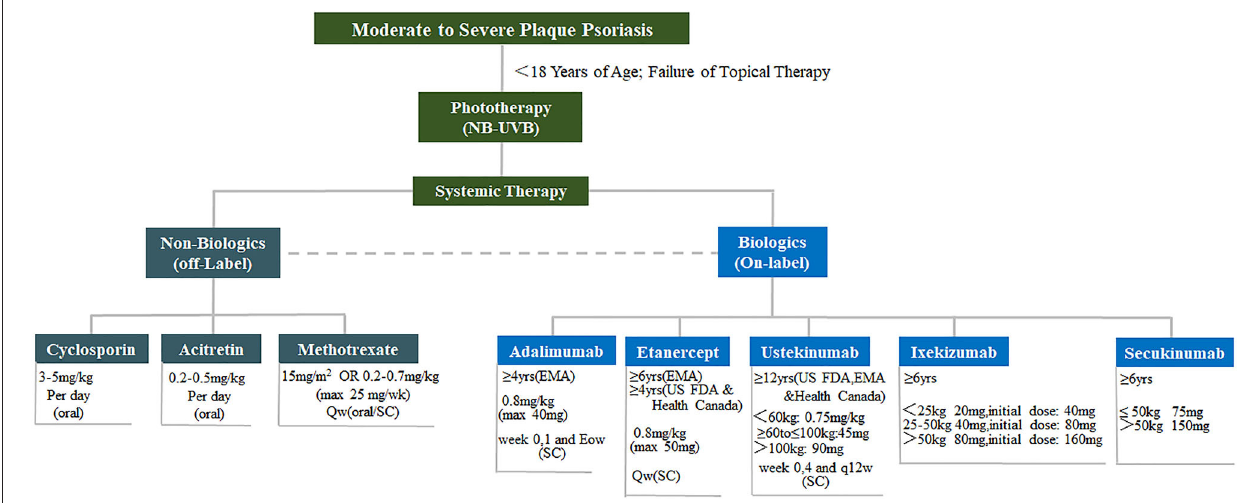
FIGURE 3 | Therapies for pediatric psoriasis. Treatment of moderate to severe pediatric psoriasis. Non-biologics include cyclosporin, acitretin and methotrexate. Biologics include adalimumab, etanercept, ustekinumab, and ixekizumab. NB-UVB , narrow bound ultra violet B light.